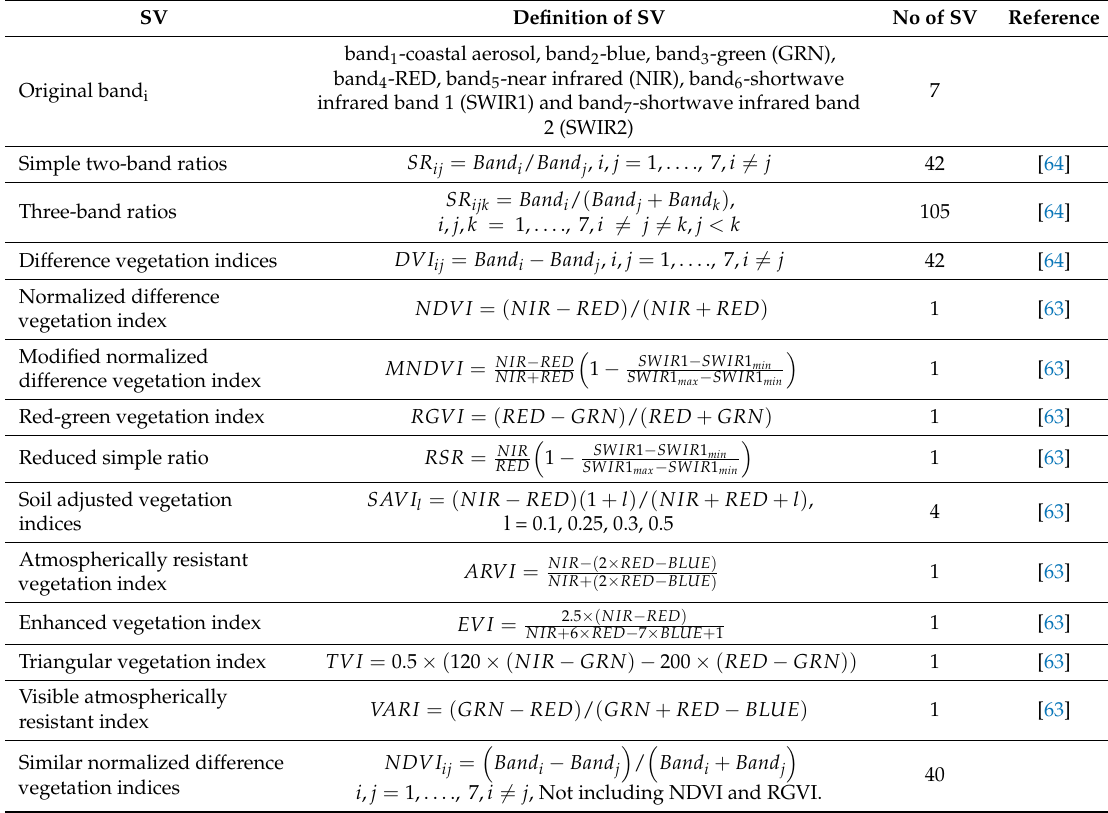
Table 1. Spectral variables (SV) extracted from the Landsat 8 OLI